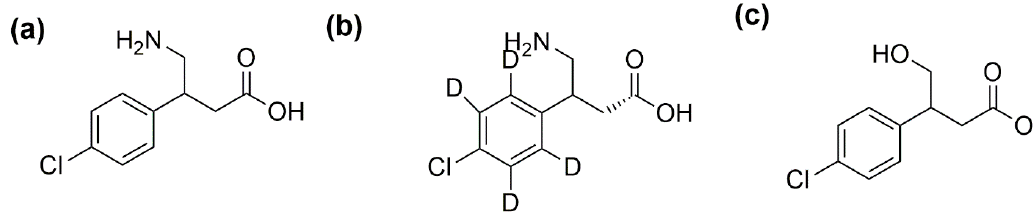
Figure 1. The chemical structure of ( a ) baclofen, ( b ) baclofen-d4, and ( c ) 3-(4-chlorophenyl)-4 hydroxybutyric acid (CHBA) metabolite.